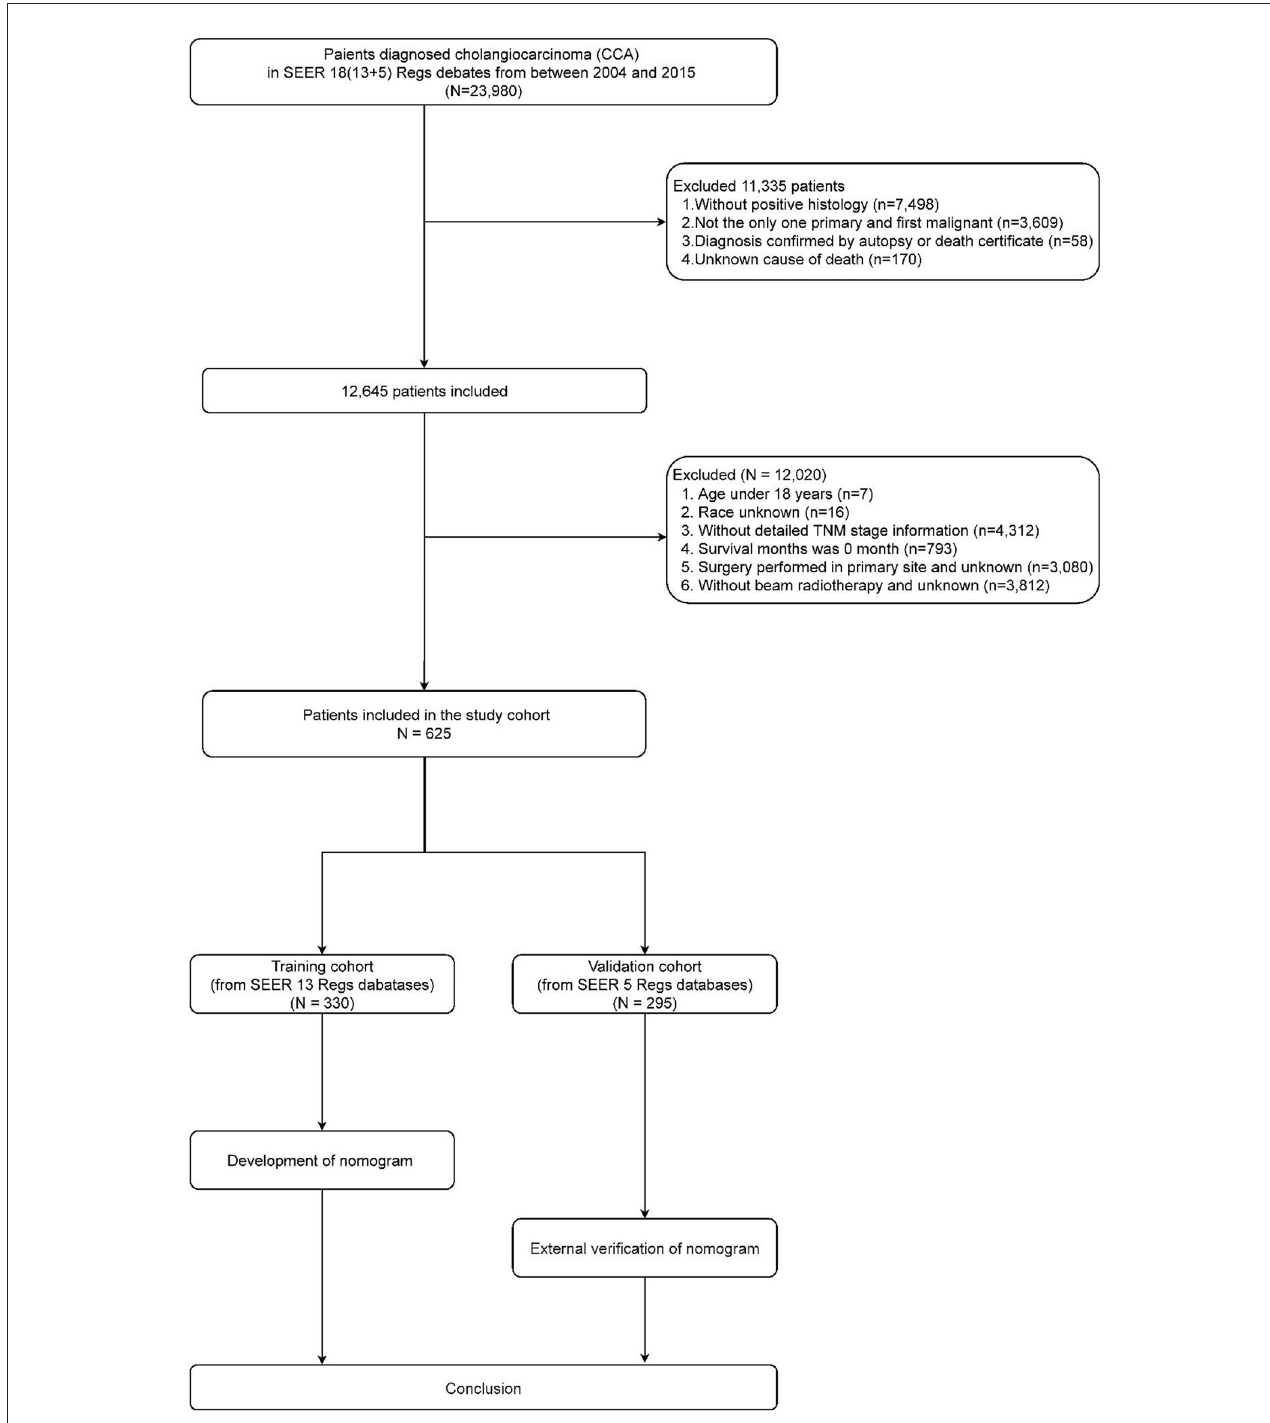
FIGURE1 Flow chart for cholangiocarcinoma patients.